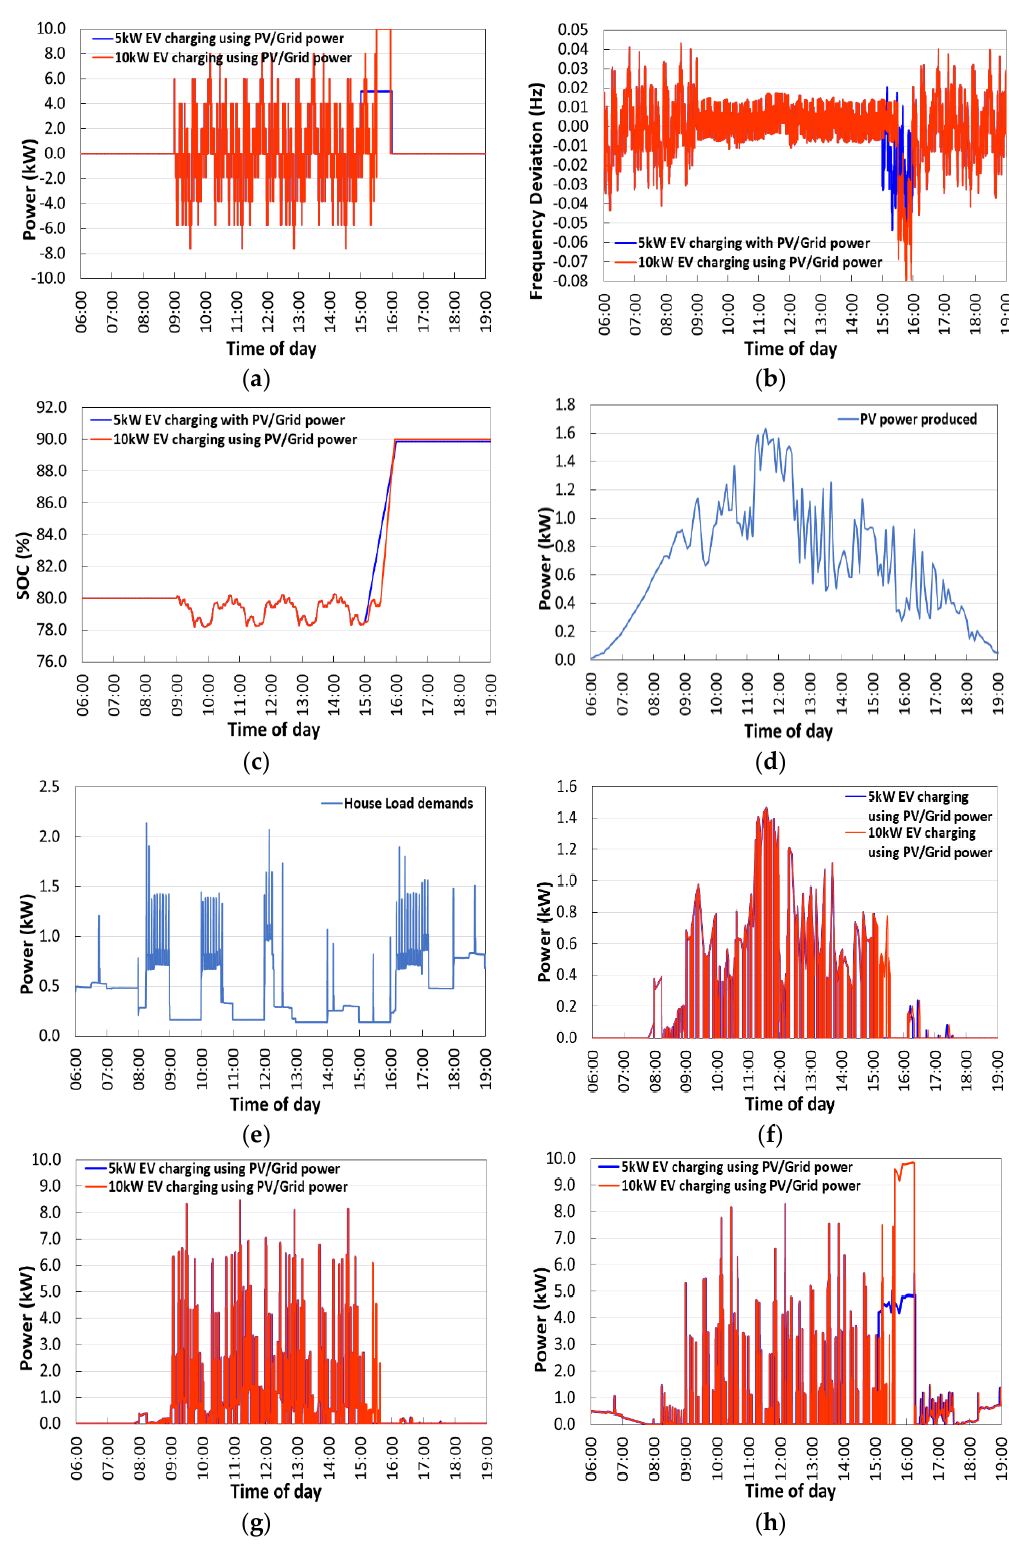
Figure 15. Simulink-based simulation of ( a ) AC output from DCFC/EV (positive: charging, negative: discharging), ( b ) frequency deviation, ( c ) SOC variation, ( d ) PV power, ( e ) house load, ( f ) power flow from PV to the external grid after the supporting load and V2G, ( g ) power flow from combined PV and V2G to external grid, and ( h ) power flow from external grid to nanogrid for PFC operation in single-vehicle-based V2H/V2G (starting SOC: 80%, duration: 13 h from 06:00 to 19:00).